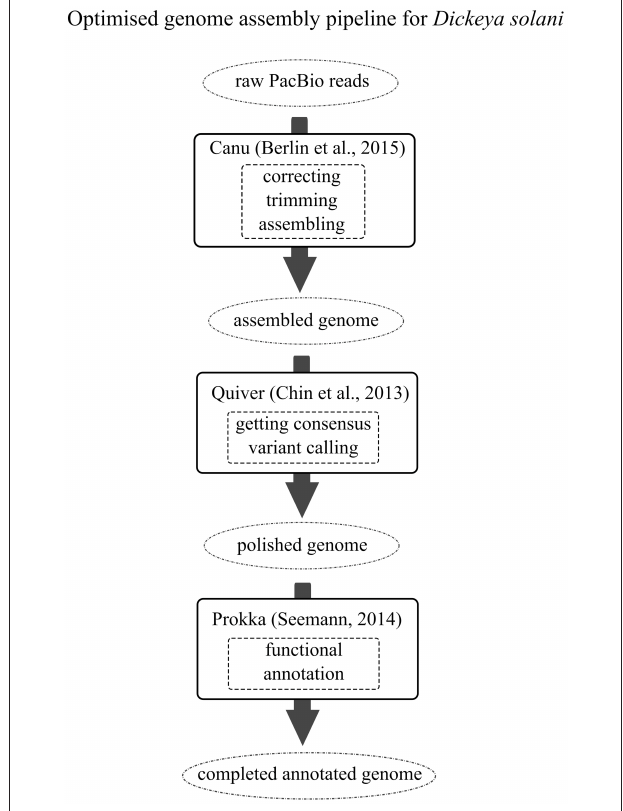
FIGURE 1 | The optimized genome assembly pipeline for D. solani . Black arrows indicate the genomic assembly pipeline to follow. Different completeness stages of the constructed genome are presented within the dotted circles. Black boxes include data on the open source software and the corresponding literature references. Functions provided by certain software are enclosed within the dashed